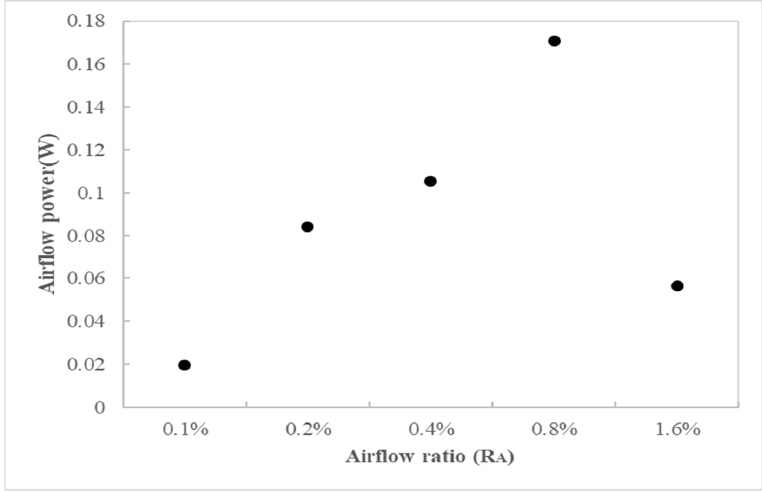
Figure 10. Average pneumatic power corresponding to the area ratio of orifice cross-section.